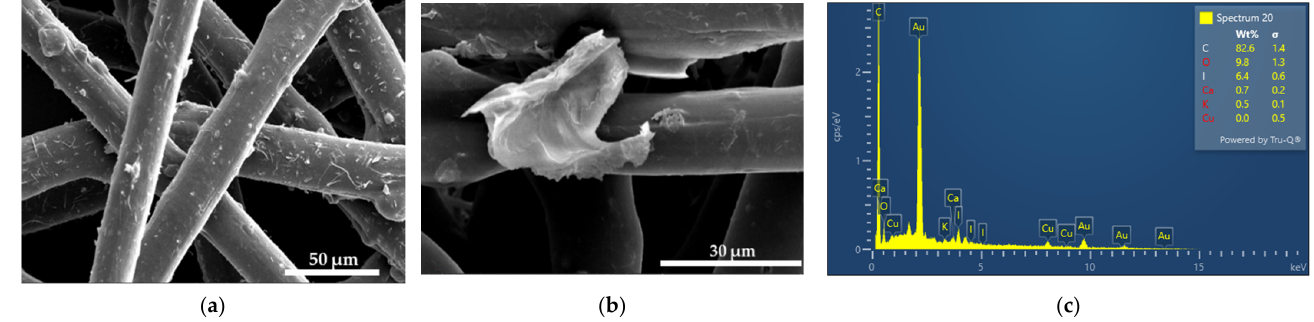
Figure 3. SEM of surgical face masks: ( a ) plain mask; ( b ) dip coated with AV-PVP-TCA-I 2 ; ( c ) EDS of coated face mask.